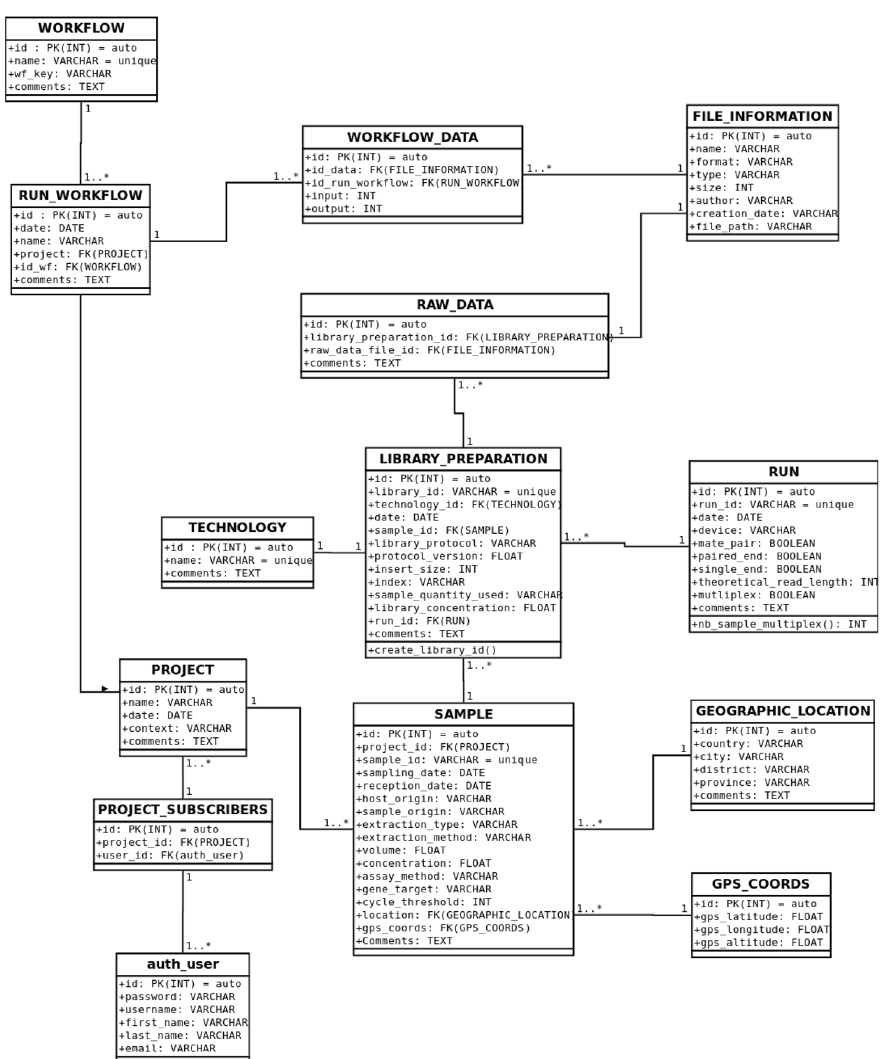
Figure S1. LIMS database